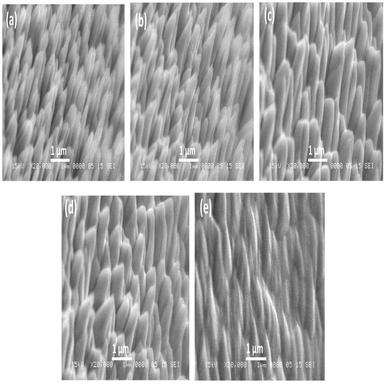
(a-e) Side view SEM images showing the morphology of AuNPs at the 5 typical regions, 1 ~ 5, respectively.